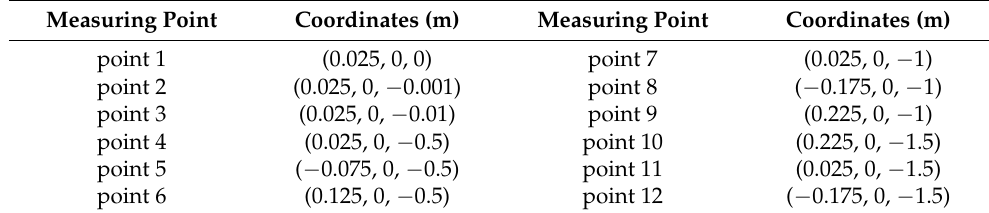
Figure 3. Three-dimensional geometric model of gas leakage and diffusion: ( a ) leakage space; ( b ) pipeline and leakage section; ( c ) monitoring surface and distribution of measuring points. Table 2. Coordinates of different measuring